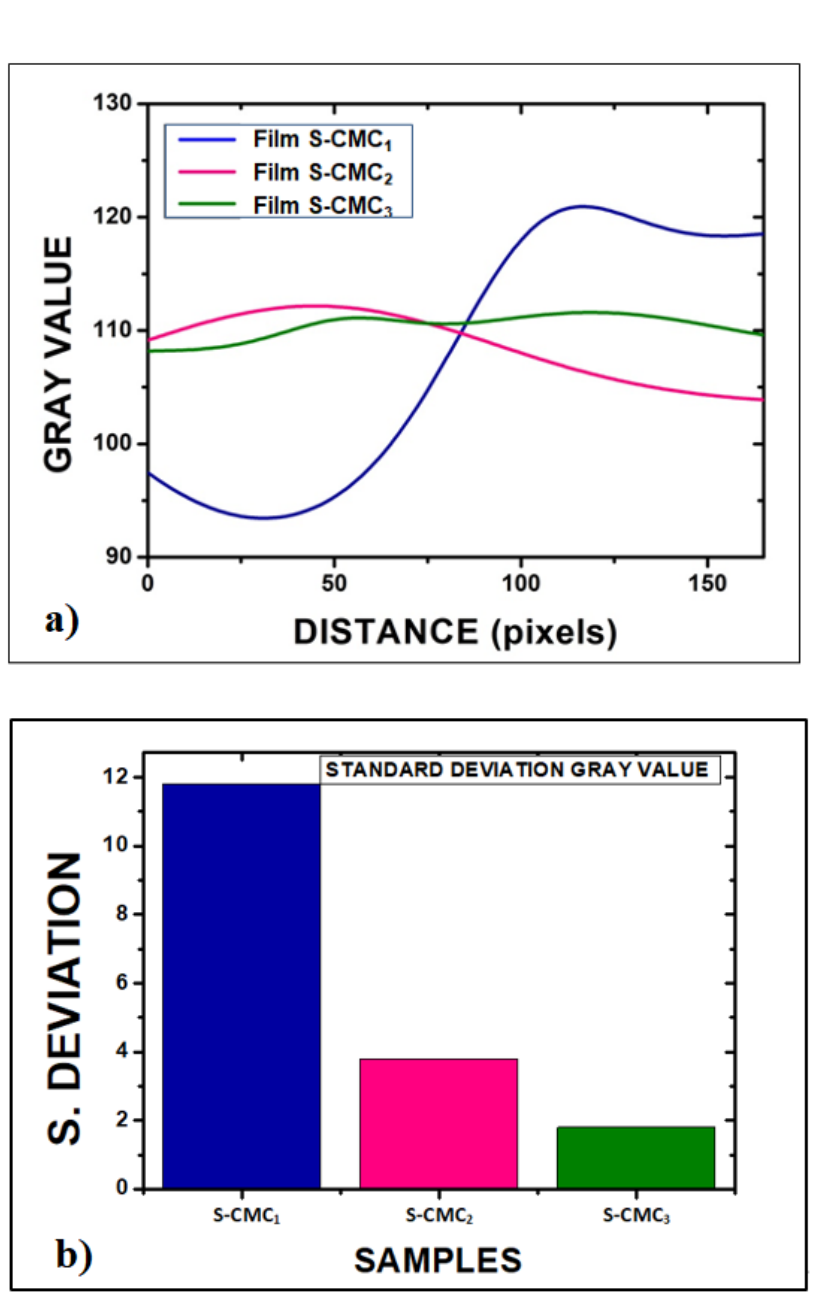
Figure 5. Quantitative assessment of the inhomogeneity degree of films: ( a ) Plot of the average of each sample profile function, after the optical image conversion into grayscale images by ImageJ software; ( b ) standard deviation of grey values related to inhomogeneity of films (11.8 for S-CMC 1 ; 3.8 for S-CMC 2 ; and 1.8 for S-CMC 3 ).